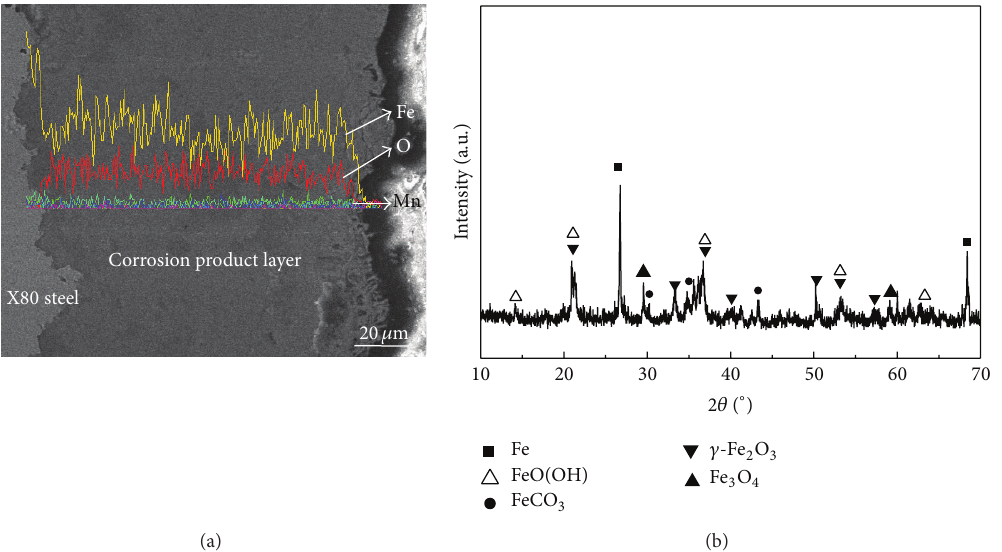
Figure 6: Sectional morphology and element composition (a) and XRD pattern (b) of corrosion product layers on X80 steel in red soil for 5